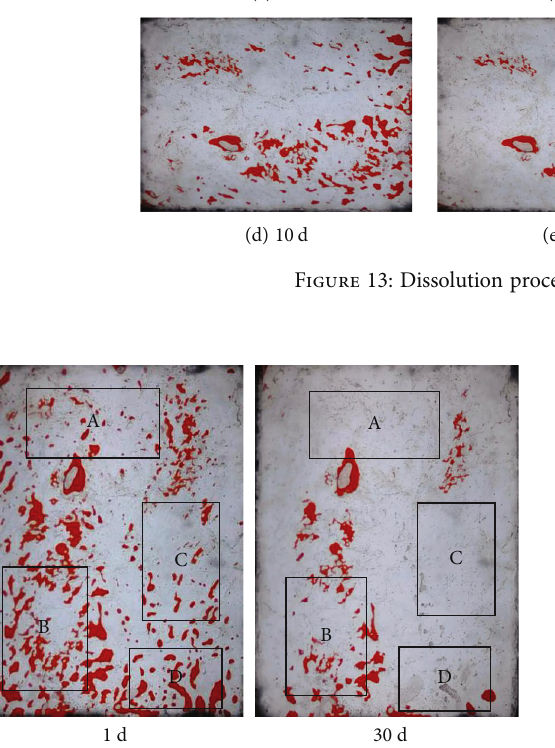
Figure 14: Comparison of PCE residue distribution.